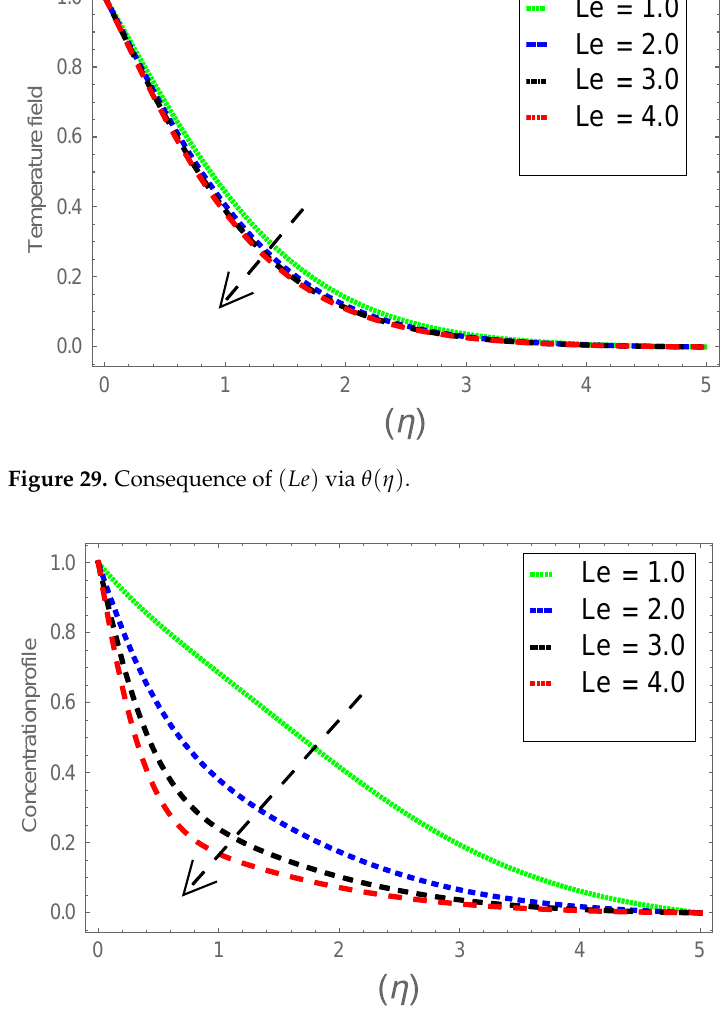
Figure 30. Consequence of ( Le ) via φ ( η )